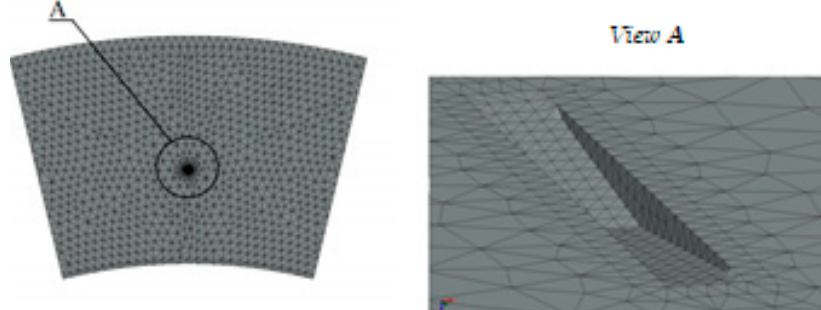
Figure 6. Conditions of the disc fastening.